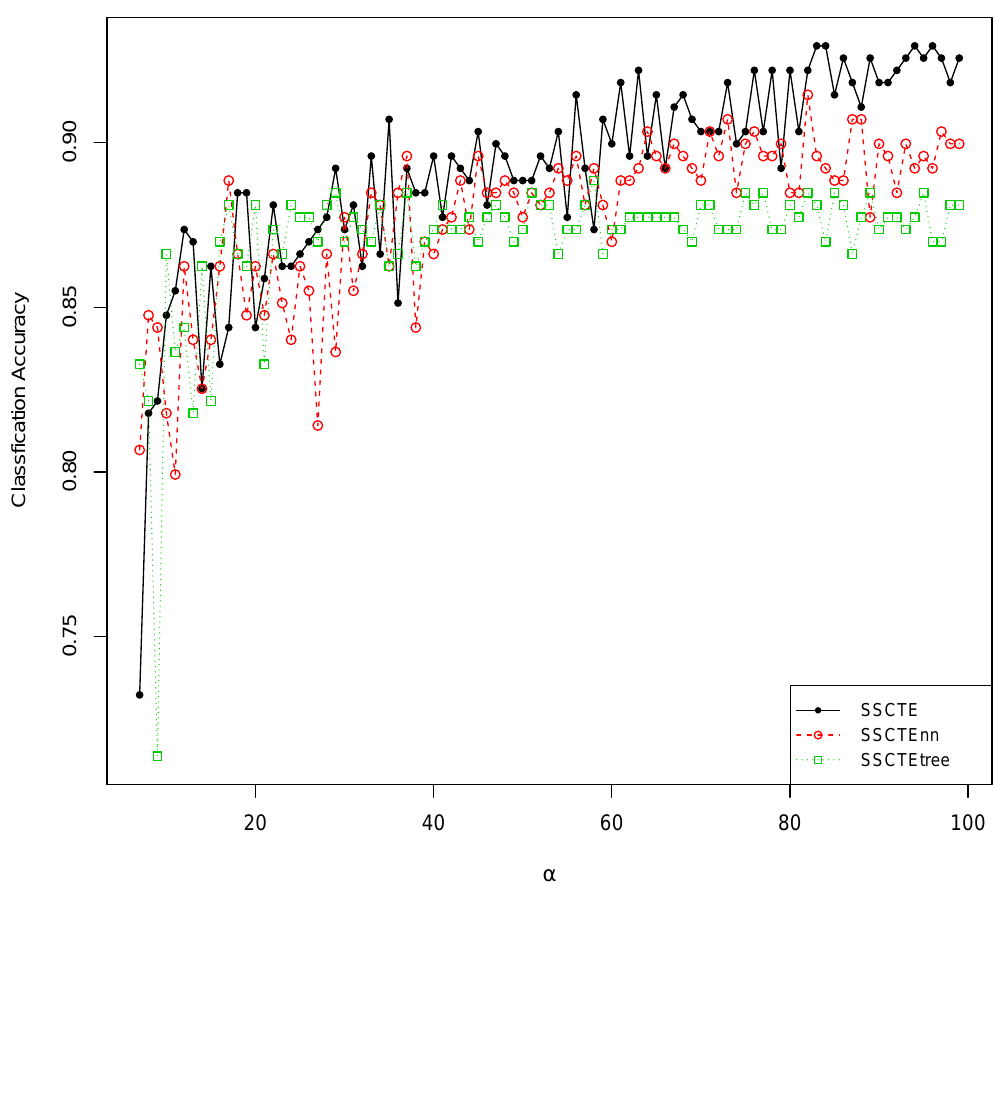
Figure 6. SSCTE variants’ performance in terms of classification accuracy